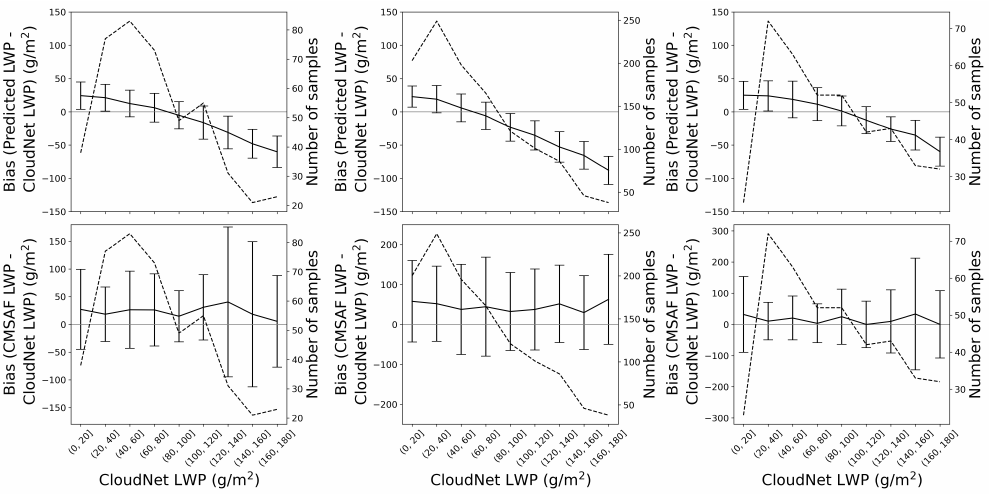
Figure 3. Bias calculated for bins of 20 g m − 2 from instantaneous LWP retrieved by the GBRT model ( top ) and CLAAS-2 ( bottom ) as a function of CloudNet LWP for Leipzig ( left ), Lindenberg ( middle ), and Juelich ( right ) for homogeneous cloud fields without feature selection. The error bars are for one standard deviation of samples in each bin. The dotted line indicates the number of samples.